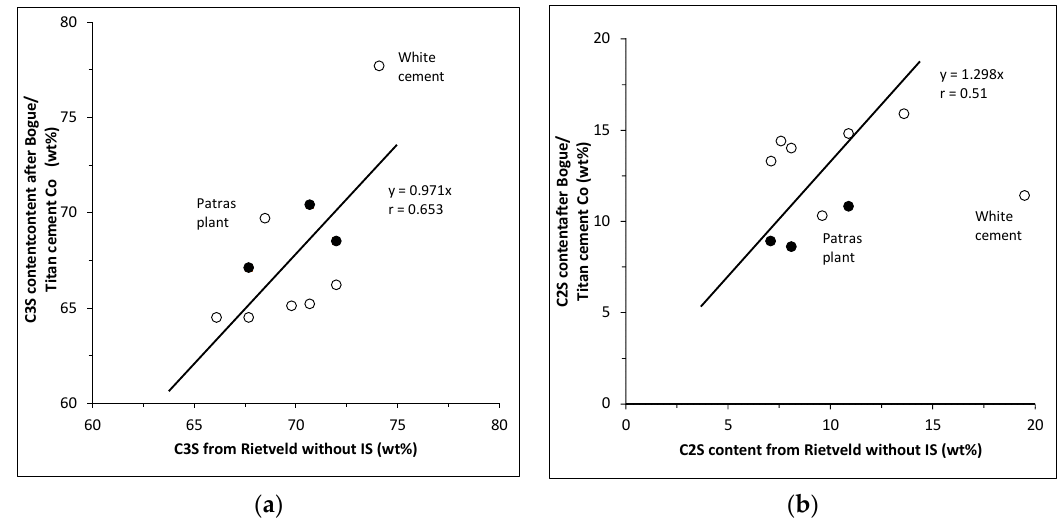
Figure 1. ( a ) C3S content (wt%) and ( b ) C2S content (wt%) of the clinkers determined by the Rietveld approach without IS and the Bogue equations (open circles). The closed circles indicate the C3S and C2S contents of the clinkers determined by the Rietveld approach without IS and the Titan Cement Co.